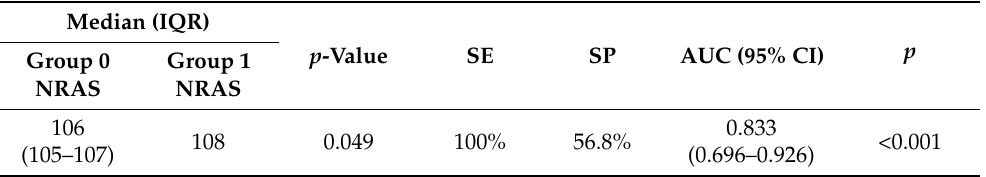
Table 2. Discretized HU Q1 results. Note: IQR could not be calculated, as group 1 only comprised